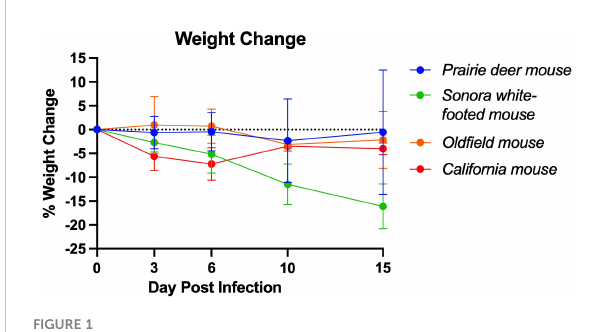
FIGURE 1 Mean weight change of deer mouse species during SARS-CoV-2 infection. On day 3 post-challenge, the California mice had signi fi cantly greater weight loss than the prairie deer mouse (p=0.004), Sonora white-footed mouse (p=0.027), and Old fi eld mouse (p=0.010). At 6 days post-challenge, the California mice had signi fi cantly greater weight loss than the prairie deer mice (p=0.016) and the Old fi eld mice (P=0.005). Points represent mean weight change of the group. Full list of p-values as calculated by unpaired t-test available in Supplementary Table 1. For each group, n=9 on day 3, n=6 on day 6, n=3 on day 15 except group D, for which n=2 on day